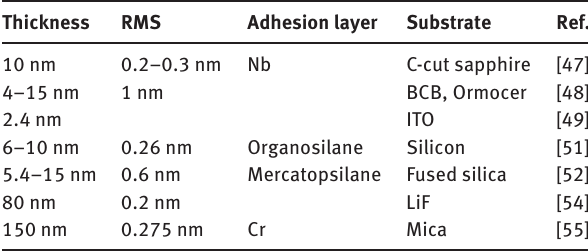
Table 1: Thin Au film parameters on different substrates and using various adhesion